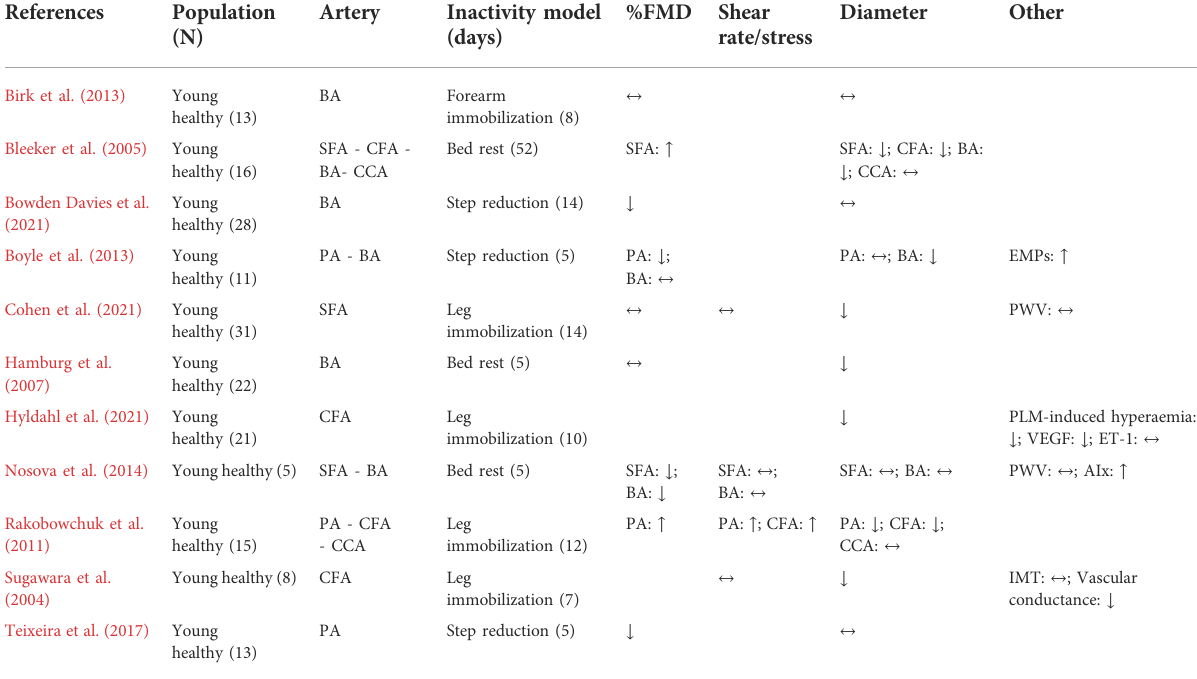
TABLE 2 The effects of short-term inactivity on vascular health